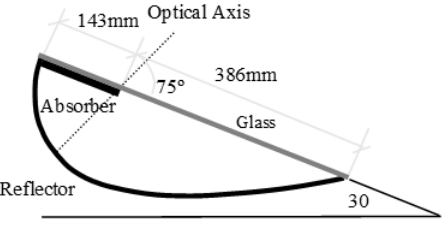
Figure 6. Diagram of spring/fall MaReCo for roof tilt 30° [23].